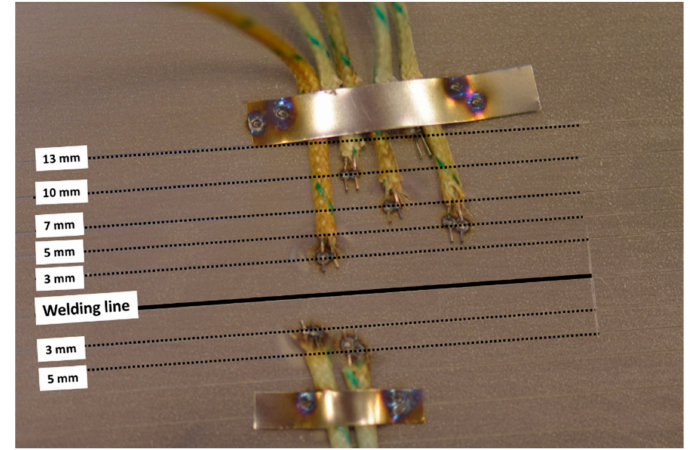
Figure 1. Position of thermocouples regarding the distance from the welding bead. Thermocouples were spot welded on the sample at distances of 3, 5, 7, 10, and 13 mm from the weld